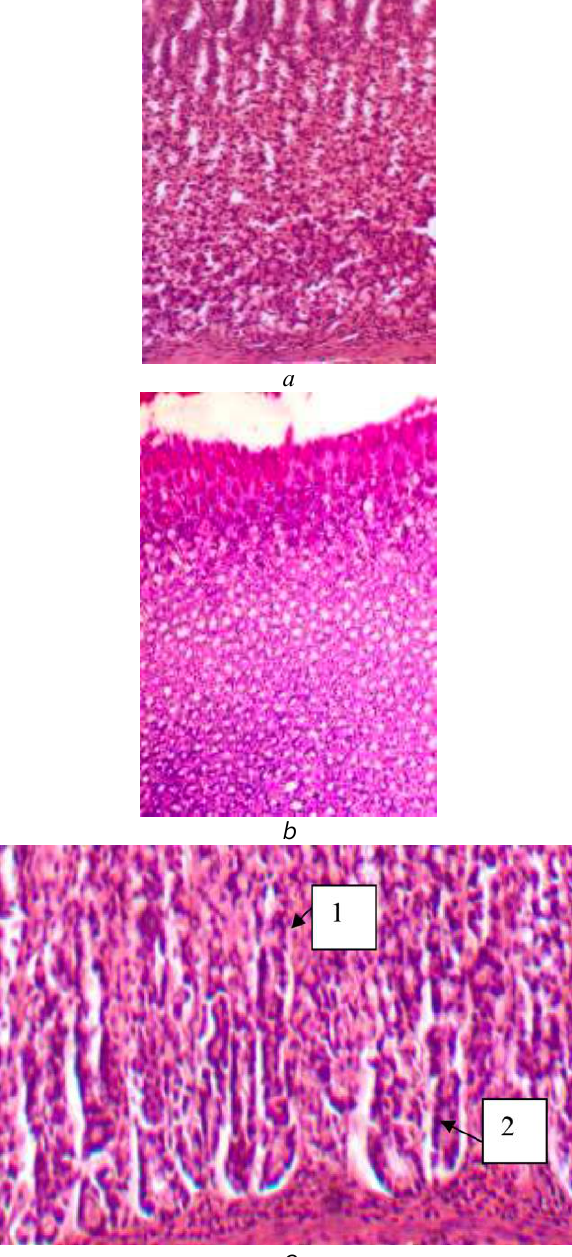
Fig. 1. Fundamental portion of the stomach of intact rats: a – normal state of the covering-patchy epithelium, glan- dular cells of the mucous membrane glands (hematoxy- lin-eosin, ×100); b – significant content of PAS-positive material in mucus-forming cells (PAS -reaction, ×400); c – normal functional state parietal (1) and major (2) cells of their own glands. Haematoxylin-eosin. ×400 Between the zone of the bottom and the pyloric area, the prepyloric zone is isolated, in which the so- called intermediary glands are located. In their structure, they resemble both their own and pyloric